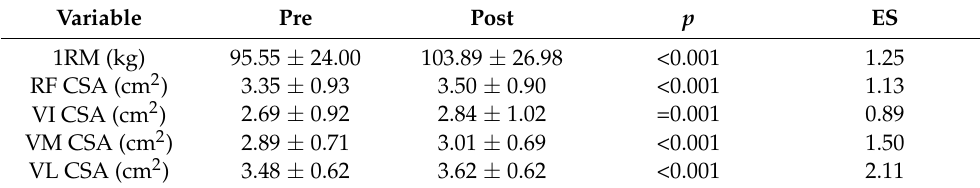
Table 1. Pre-to-post changes in 1RM and CSA of quadriceps muscles.